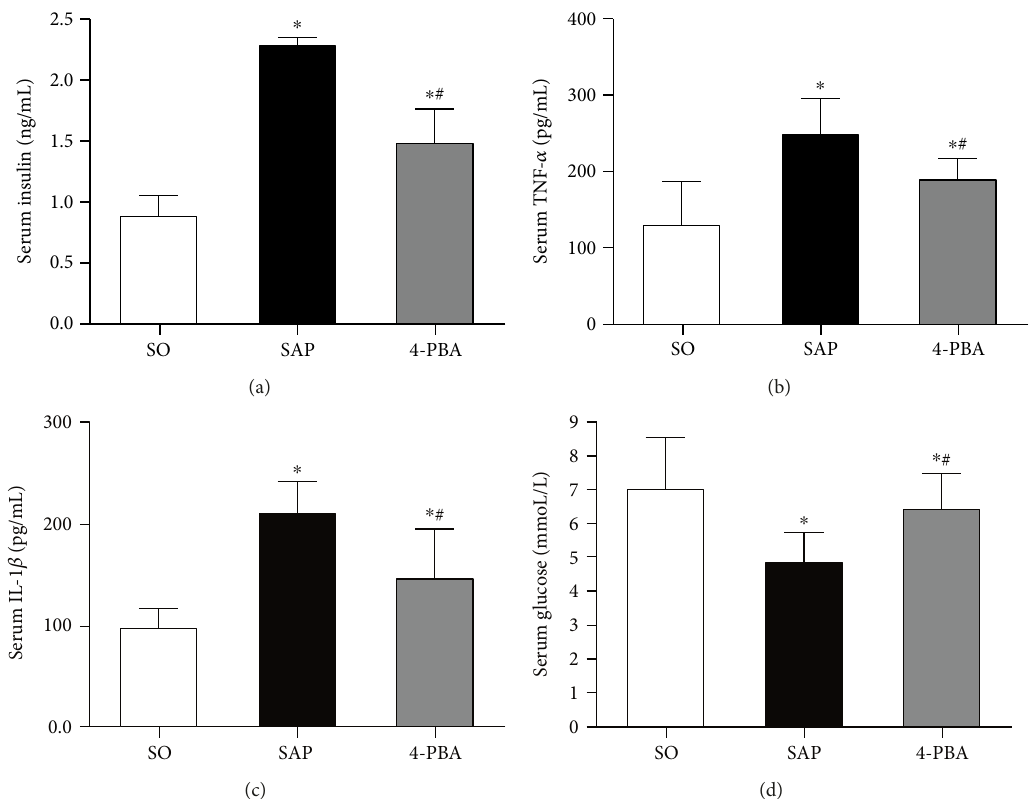
Figure 4: E ff ects of 4-phenylbutyric acid on insulin, in fl ammatory cytokine, and glucose production in serum. (a) Insulin; (b) TNF- α ; (c) IL-1 β ; (d) glucose. Each value represents the mean ± standard deviation. ∗ P < 0 05 versus SO group; # P < 0 05 versus SAP